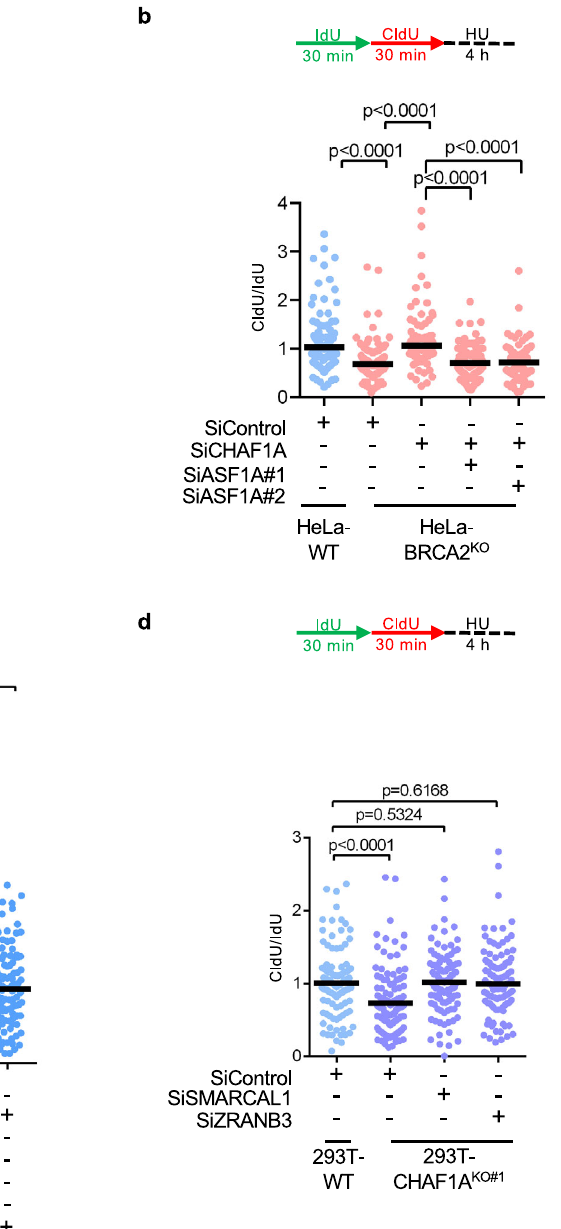
Fig.3|DeterminantsofCHAF1A-mediatedforkprotection.a DNA fi bercombing assayshowingthatASF1AdepletionresultsinHU-inducedforkdegradationinwild- type cells, but does not affect this degradation in BRCA1 or BRCA2-depleted HeLa cells. The ratio of CldU to IdU tract lengths is presented, with the median values markedonthegraph.The p -values(Mann – Whitneytest,two-tailed)arelistedatthe top. A schematic representation of the DNA fi ber combing assay conditions is also presented.Westernblotscon fi rmingtheco-depletionareshowninSupplementary Fig. 3a. b DNA fi ber combing assay showing that ASF1A co-depletion restores HU- induced fork degradation in CHAF1A-knockdown HeLa-BRCA2 KO cells. The ratio of CldUtoIdUtractlengthsispresented,withthemedianvaluesmarkedonthegraph. The p -values (Mann – Whitney test, two-tailed) are listed at the top. A schematic representation of the DNA fi ber combing assay conditions is also presented. Wes- tern blots con fi rming the co-depletion are shown in Supplementary Fig. 3b. c DNA